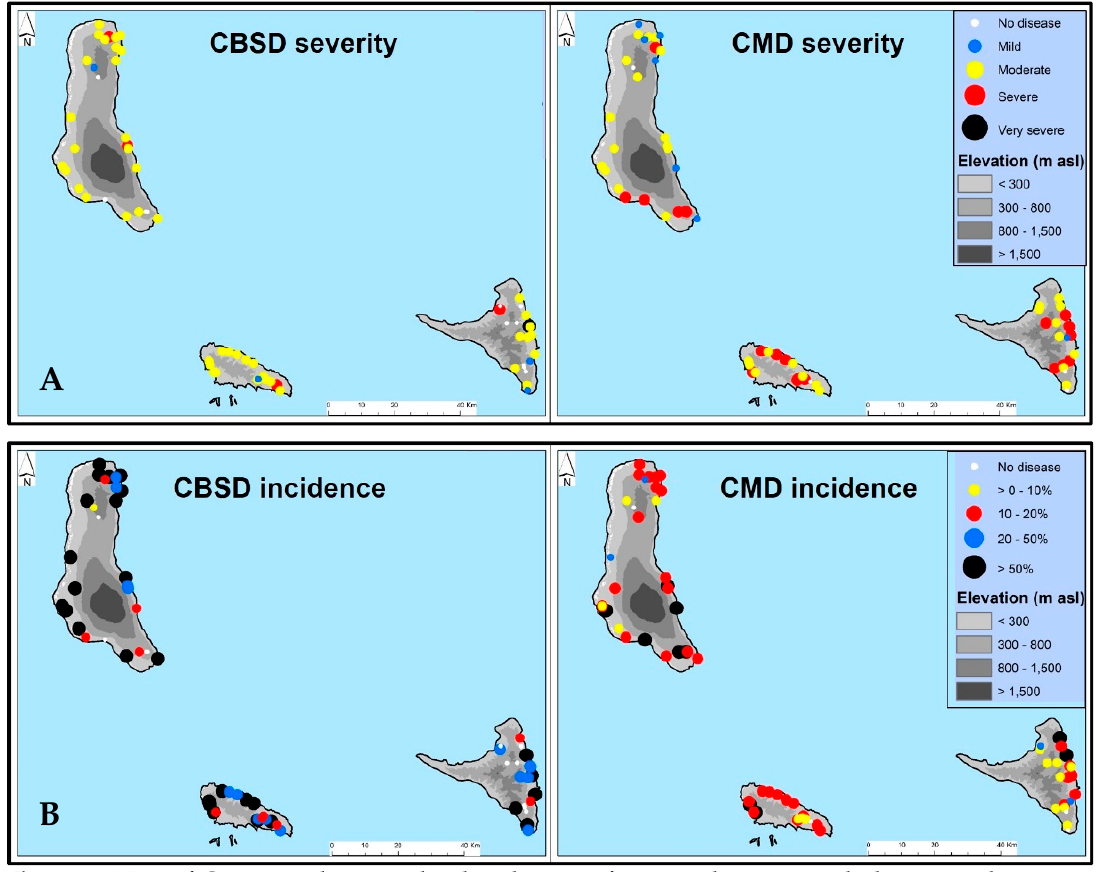
Figure 1. Map of Comoros showing the distribution of cassava brown streak disease and cassava mosaic disease in Comoros, July 2019. CBSD: cassava brown streak disease; CMD: cassava mosaic disease. ( A ) CBSD and CMD severities in Comoros, July 2019. Disease severity scores were deter- mined according to Cours, (1951) [32] and Gondwe et al. (2003) [33]. The colored bullets represent disease scores where: white = score 1 (no symptoms), blue = average score 2 (2<3; mild symptoms), yellow = average score 3 (moderate symptom), red = average score 4 (3.1<4; severe symptom), and black = average score 5 (scores 4.1 ≤ 5; very severe symptom). ( B ) CBSD and CMD incidences in Comoros, July 2019. Table 2. Comparison of cassava brown streak disease, cassava mosaic disease symptoms, and Bemisia tabaci abundance across three islands in Comoros, July